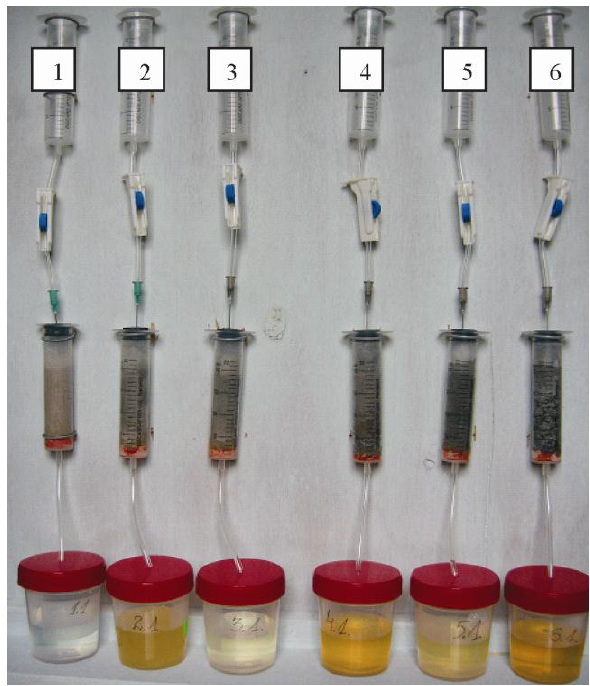
Fig. 2. Experimental board after the first day of the analysis